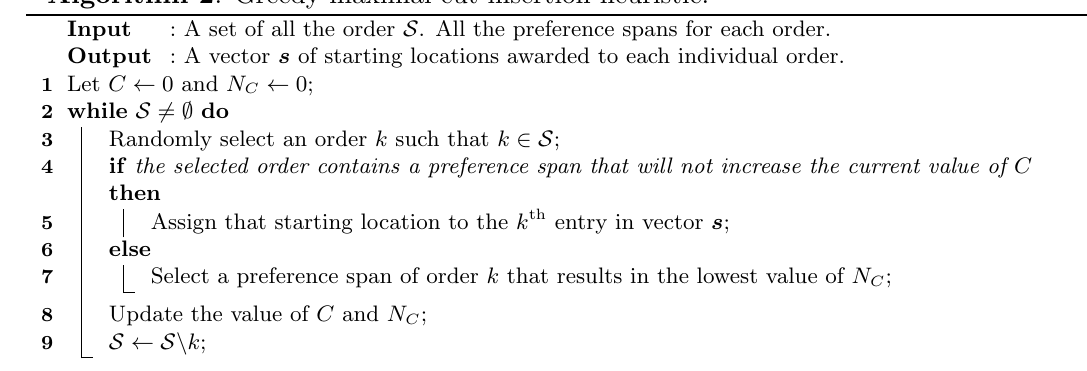
Algorithm 2 : Greedy maximal cut insertion